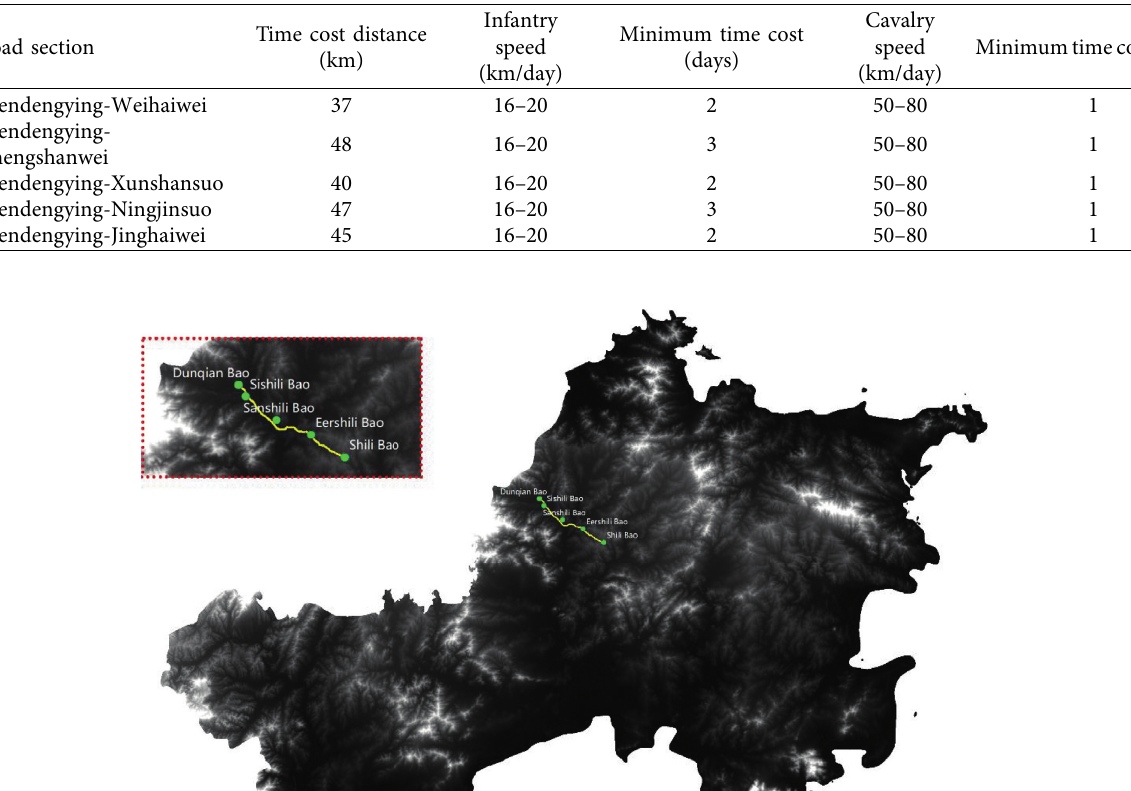
Figure 10: Simulated military paths from Wendengying to Wei City and Suo City along the coast. Table 8: Results of ancient military road traffic efficiency.